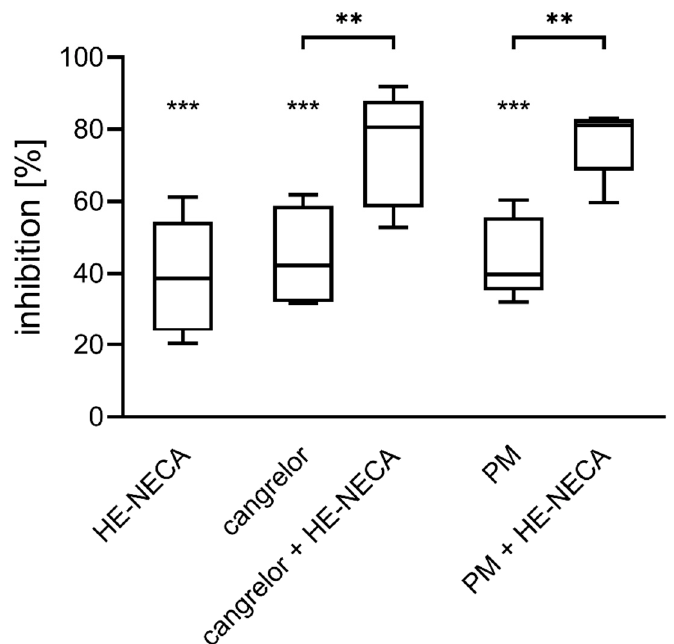
Figure 1. HE-NECA, the adenosine receptor agonist, intensifies the anti-aggregatory effect of P2Y 12 antagonists. Data are presented as median, interquartile range and minimum and maximum values ( n = 5). Changes in platelet aggregation were measured in whole blood in response to 10 µ M ADP after 3 min preincubation at 37 ◦ C with HE-NECA and/or cangrelor, or 15 min preincubation at 37 ◦ C with PM (prasugrel metabolite). Statistical significance was estimated by two-way ANOVA with Sidak’s multiple comparisons post-hoc test (only relevant comparisons were tested). ** p < 0.01, *** p < 0.005.